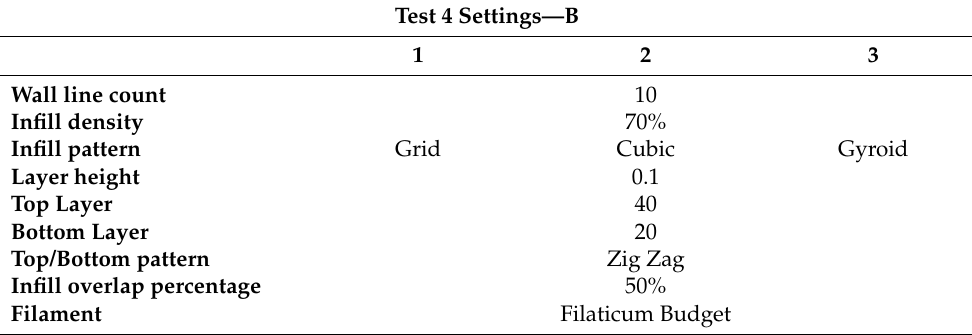
Table 10. Punch settings of Test